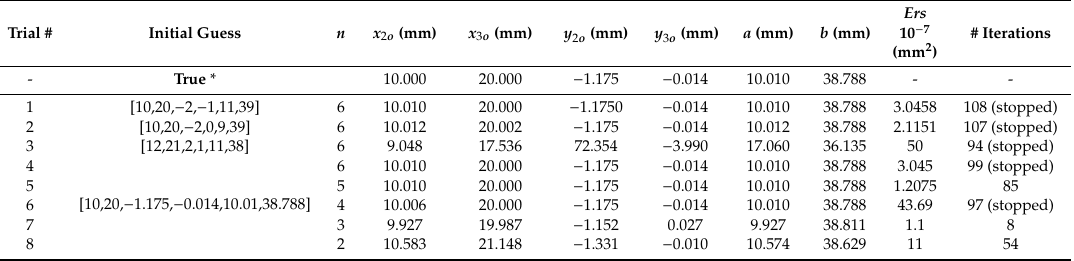
Figure 7. 2D-CAD drawing of the assembly with annotations. The global reference is fixed at the tip of sensor 1 with y+ direction to the right and x+ direction downward.